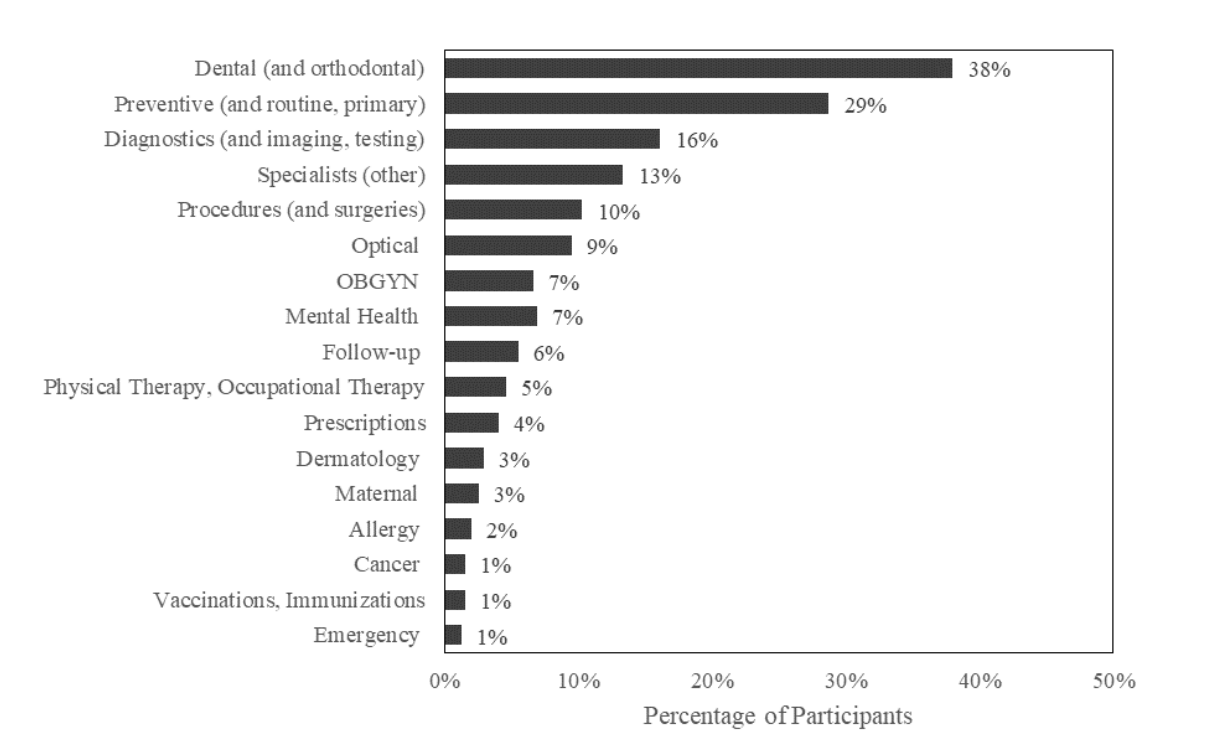
Figure 1. Types of health care impacted by the COVID-19 pandemic (n=921). Proportions do not sum to 100% because participants may have listed >1 type of care. OGBYN: obstetrics and gynecology.